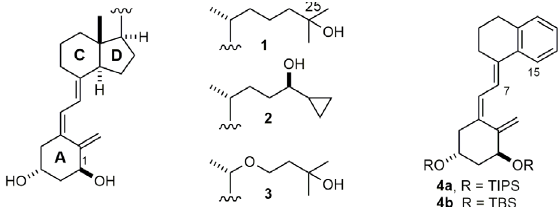
Figure 1 - Structures of 1,25D ( 1 ), calcipotriol ( 2 ), OCT ( 3 ) and target D -ring-aromatic compound